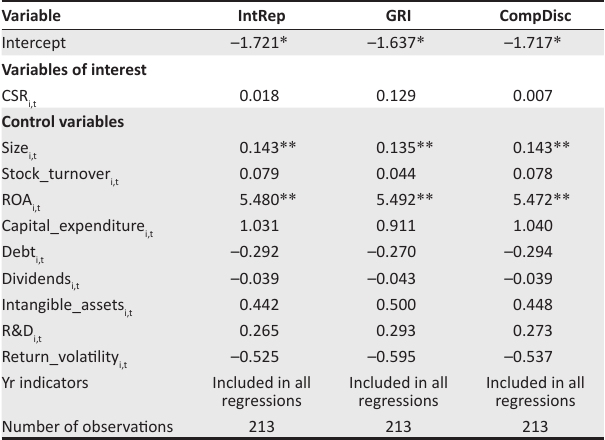
TABLE 3: Regression results for firm value – corporate social responsibility disclosure